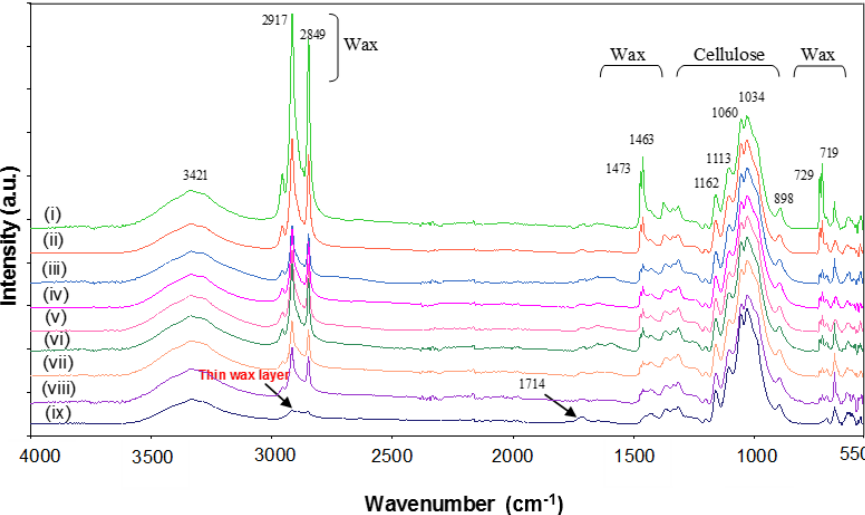
Figure 8. Fourier transform infrared (FTIR) spectra for (i) non-cured modified MFC films and after curing at different temperatures of (ii) 40 °C (iii) 60 °C (iv) 80 °C (v) 100 °C (vi)